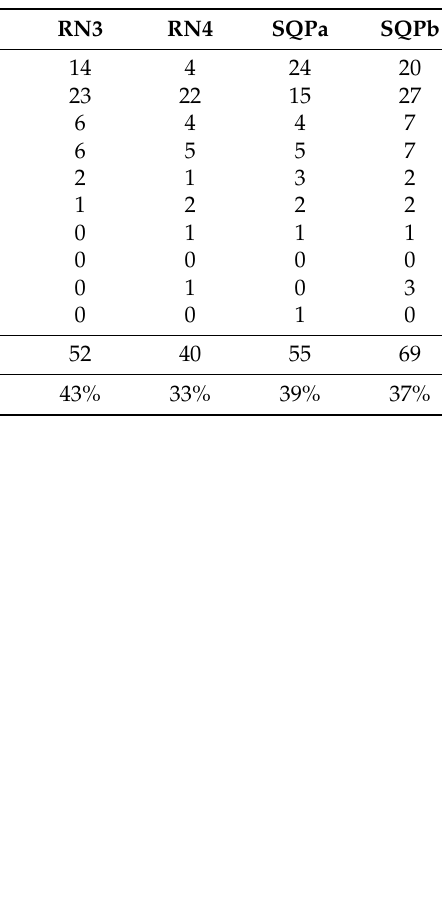
Figure 9. Total number of species collected (continuous lines) and SD species (dashed lines) collected per month in each site (NNP, Podlaskie, North-East Poland). The R value under each site represent the correlation between the total number of species collected per month in each forest site with the number of SD species collected per month in each site.